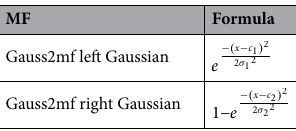
Table 4. The mathematical equation of Gaussian2 function used in this work 34 .